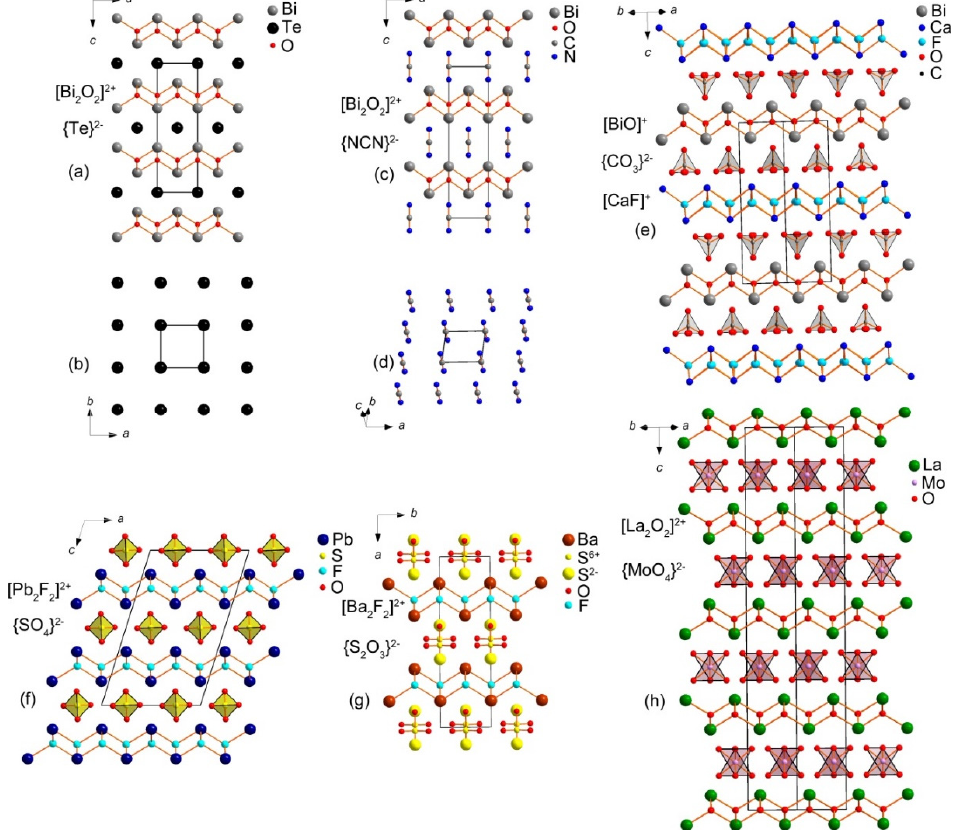
Figure 1. Sillén-type structural architectures in minerals and synthetic compounds. General projection ( a ) and interlayer ( b ) in the crystal structure of [Bi 2 O 2 ]Te [42] and its derivatives hosting molecular anions in the interlayer galleries: [Bi 2 O 2 ]CN 2 [20] ( c , d ), kettnerite [BiO][CaF][CO 3 [26] ( e ), grandreefite [Pb 2 F 2 ]SO 4 [27] ( f ), slag phase [Ba 2 F 2 ]S 2 O 3 [28] ( g ), and [La 2 O 2 ]MoO 4 [43] ( h ).